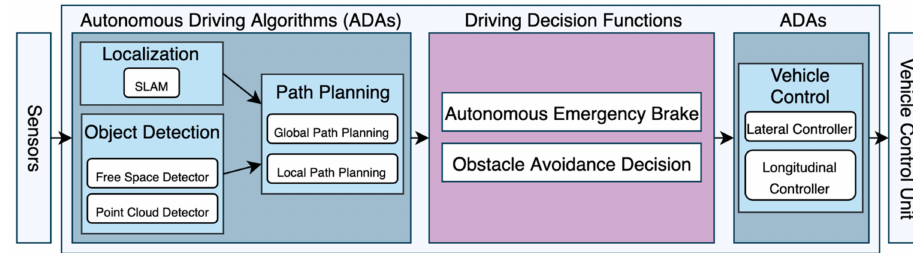
Figure 7. Block diagram of the software algorithm